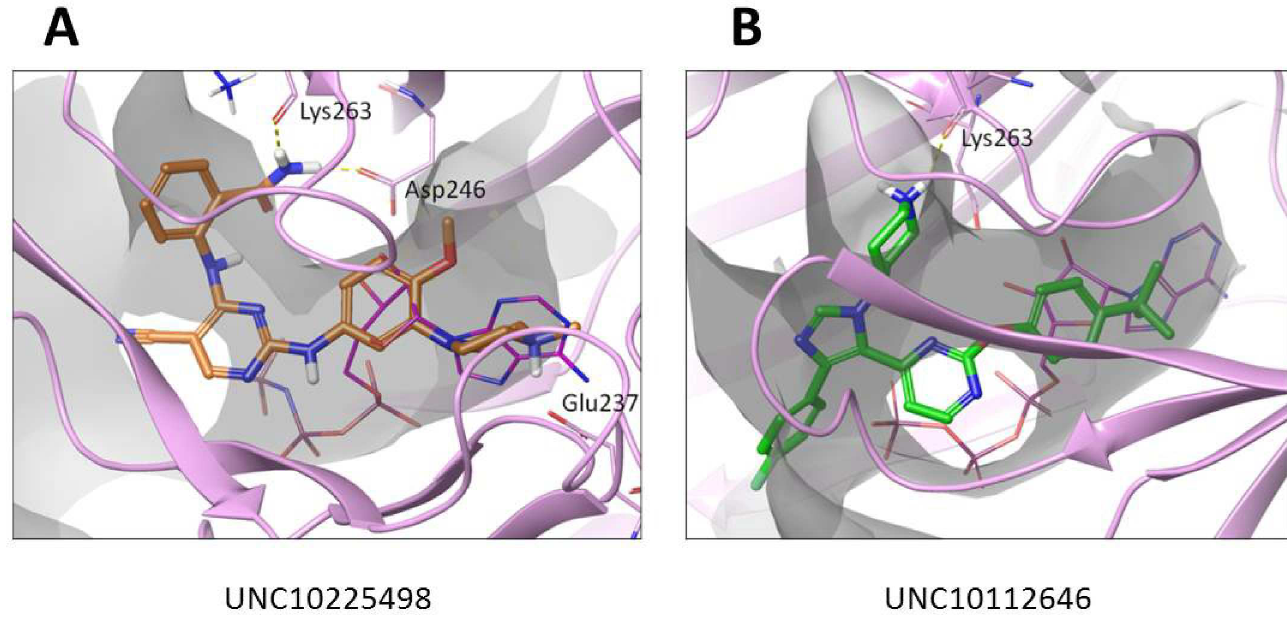
Fig 7. The docking poses of UNC10225498 and UNC10112646with PPIP5K. (A) UNC10225498 (thick sticks; orange carbons) (B) UNC10112646 (thick sticks; green carbons). The ATP pocket is outlined as a gray transparentsurface and ATP itself is depicted by thin magenta sticks. Residues predicted to interact with docked compoundsare highlighted (see text for